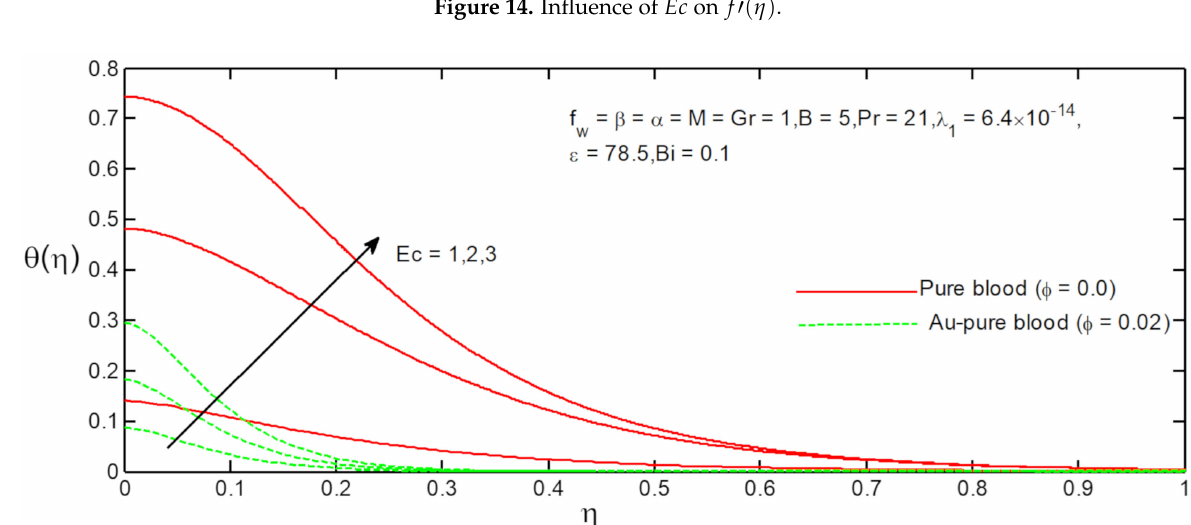
Figure 14. Influence of Ec on f (cid:48) ( η ) .